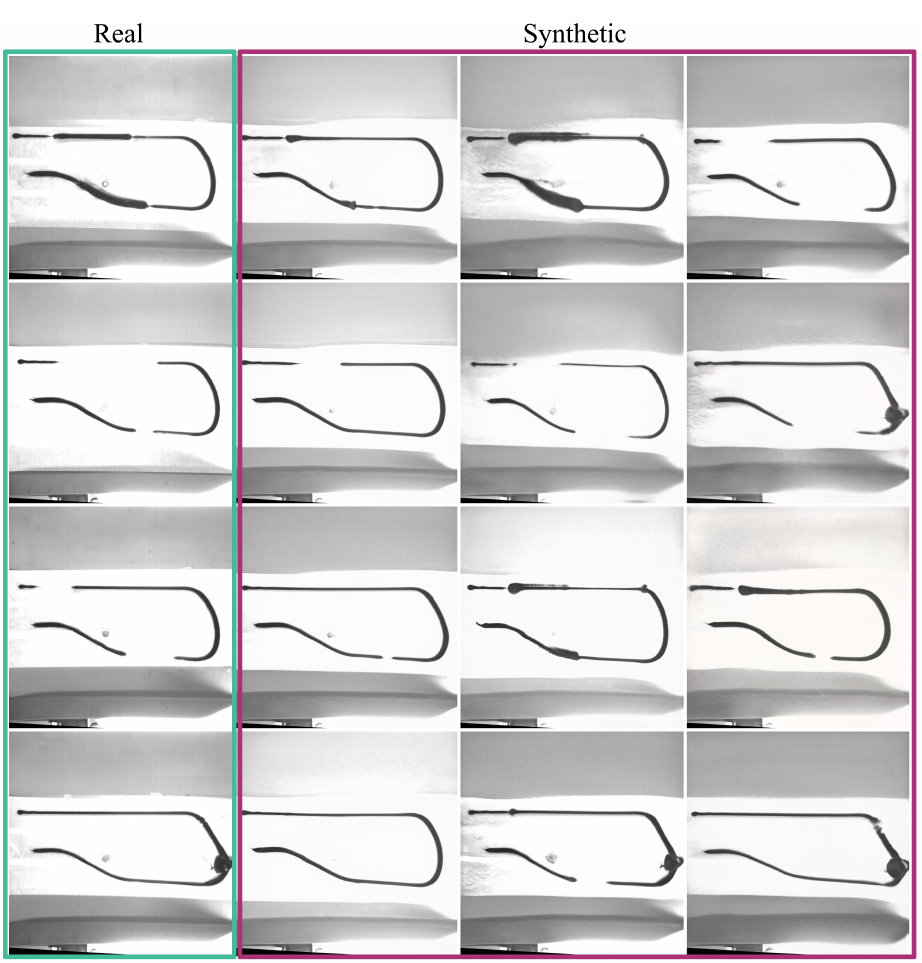
Figure 3. Real and synthetic images of defective structural adhesive beads. First column depicts real images from the original dataset. Second, third and fourth columns correspond to synthetic images generated with truncation values of 0.5, 1.5 and 2.0,